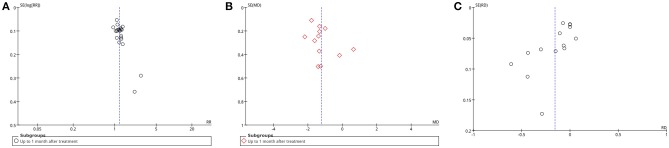
Funnel plot: (A) manual acupuncture vs. medication-effective rate-up to 1 month after treatment; (B) manual acupuncture vs. medication-VAS scores-up to 1 month after treatment; (C) manual acupuncture vs. medication-adverse events. Note: SE, standard error; RR, risk ratio.